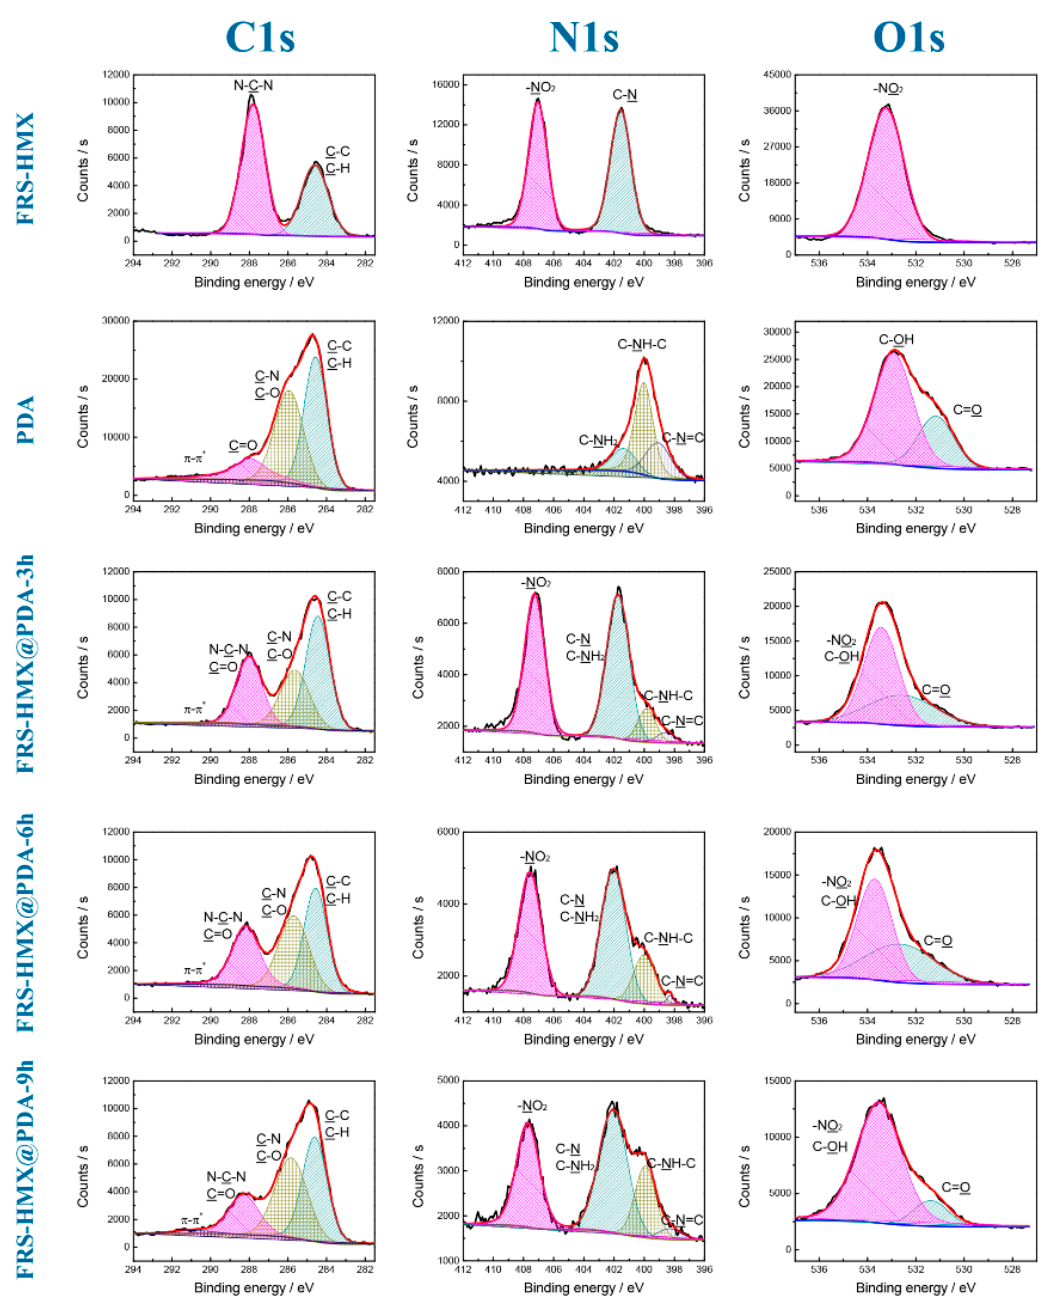
Figure 3. XPS of the uncoated FRS-HMX crystals, PDA, and FRS-HMX@PDA microparticles.